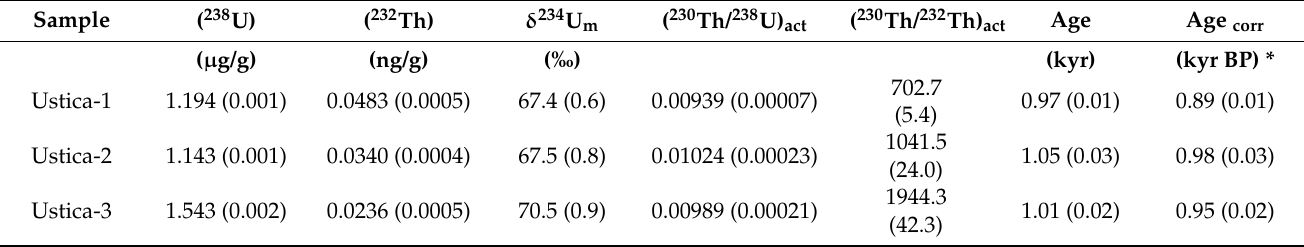
Table 2. Results of the U/Th dating of the vadose speleothem (Ustica 1, 2, 3; Figure 5). 238 U and 232 Th concentrations were determined using the enriched 236 U and 229 Th isotopes, respectively.